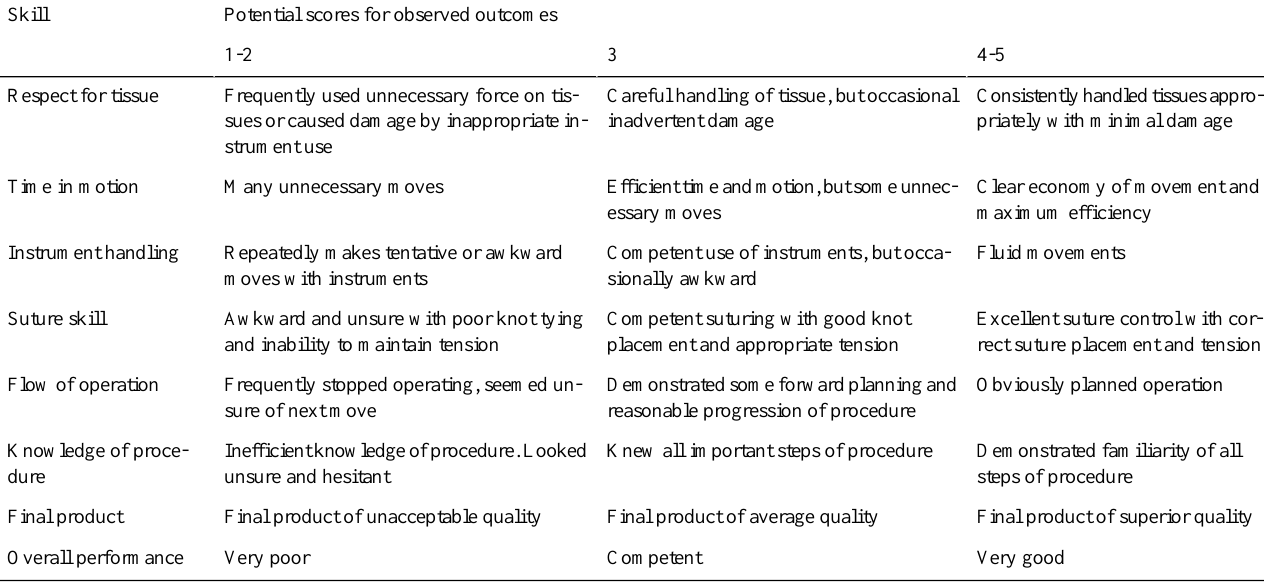
Table 1. Global Rating Scores of the Objective Structured Assessment of Technical Skills [8,33,34]. The students will be asked to rate the candidate’s performance on a scale of 1 to 5, and the total score will be